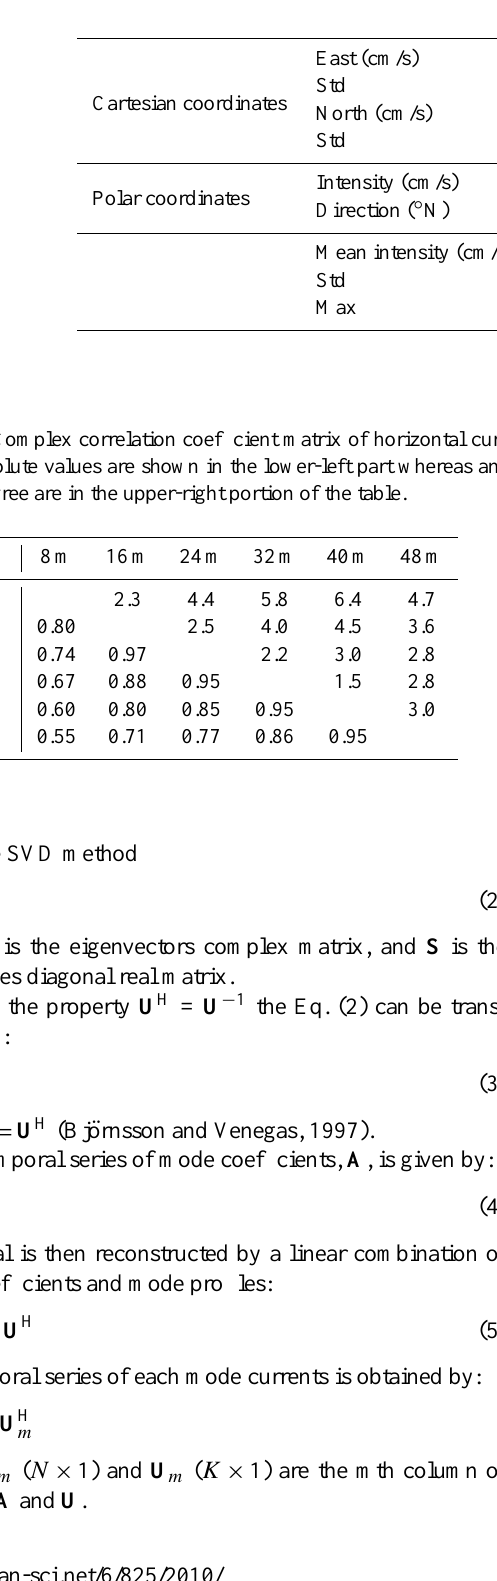
Table 2. General statistics of currents for each level of the profile: mean velocities in Cartesian (East and North components with standard deviation) and Polar (intensity and direction) coordinates; mean of velocity intensities with relative standard deviation and maximum. Levels of the ADCP